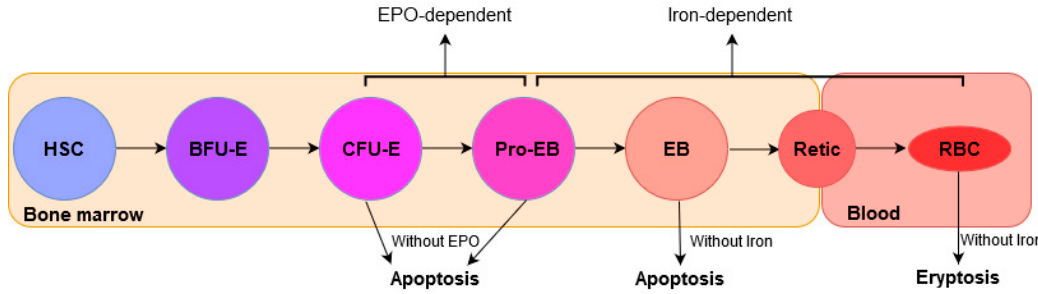
Figure 4. Overview of erythropoiesis. HSC differentiates into RBC, as indicated by the arrows. Stages of erythropoiesis EPO-dependent and Iron-dependent are indicated. Abbreviations are: HSC, hematopoietic stem cell; BFU-E, burst-forming unit-erythroid; CFU-E, colony-forming unit-erythroid; Pro-EB, proerythroblasts; EB, erythroblasts; Retic, reticulocytes; RBC, mature RBCs; EPO, erythropoietin.